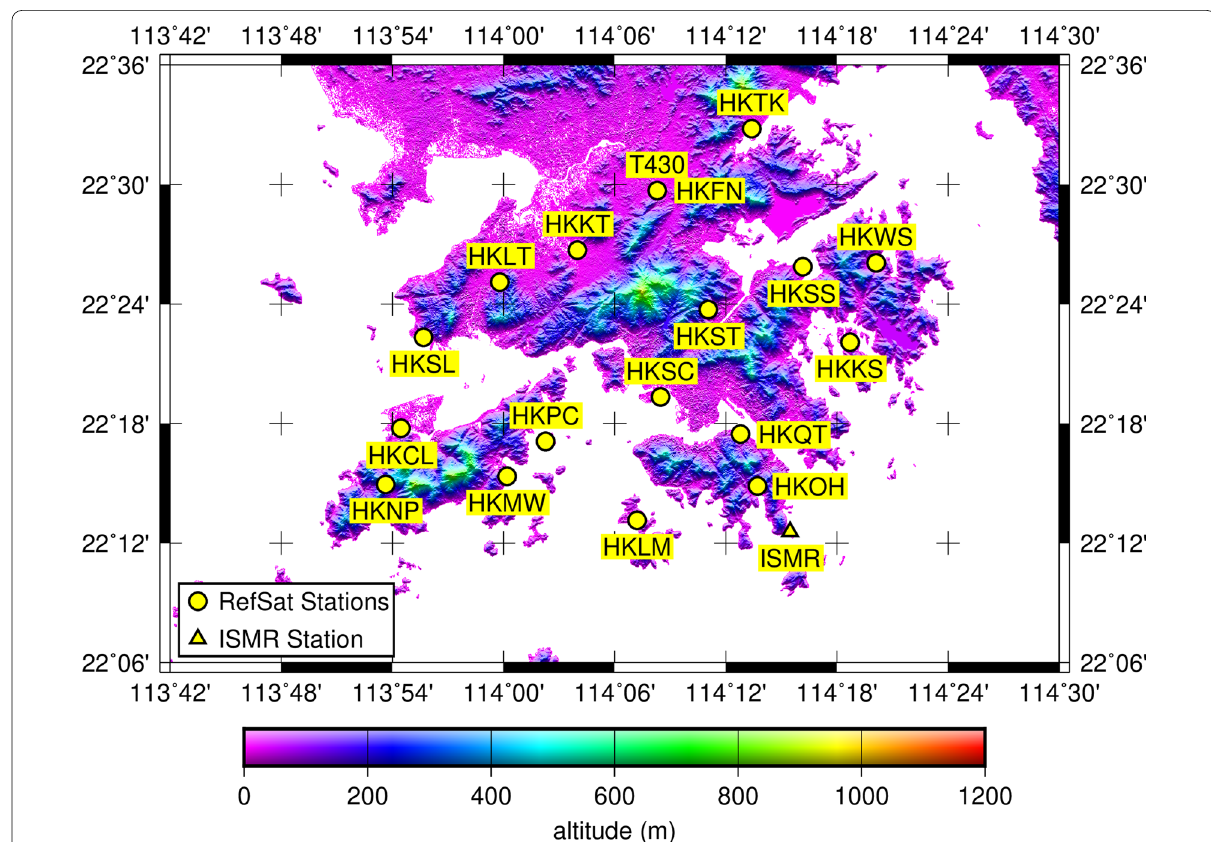
Fig. 3 The spatial distribution of the SatRef and ISMR stations. The yellow circles denote the SatRef stations; the yellow triangle denotes the ISMR station. The background color represents the digital elevation model (DEM) of Hong Kong with the resolution of 30